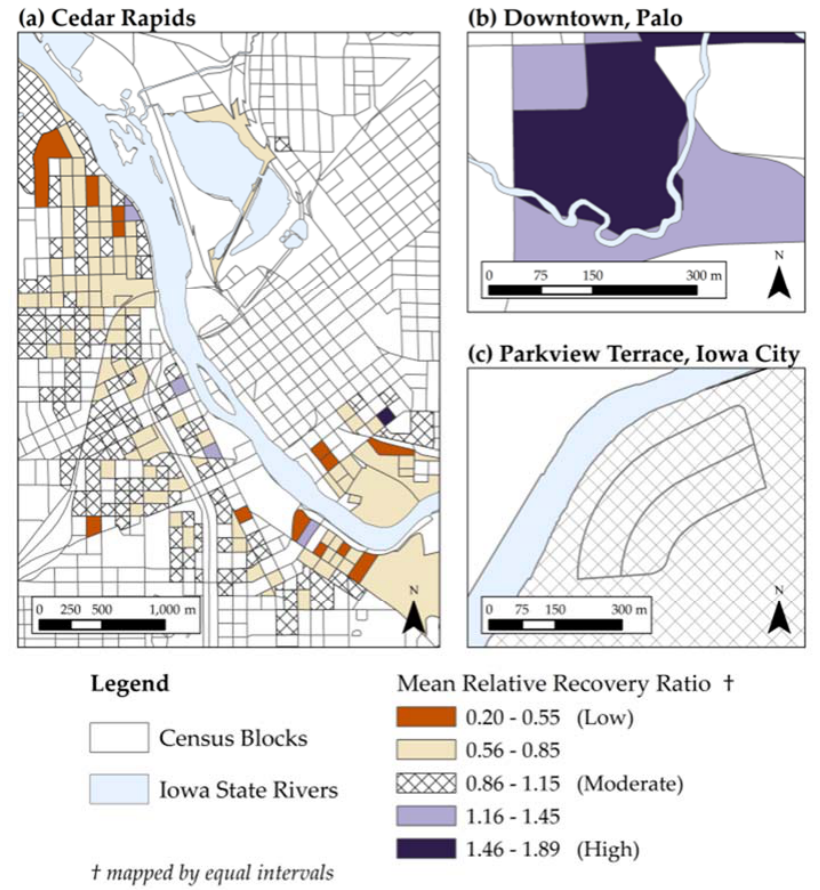
Figure 3. Spatial distribution of RRR values by city: ( a ) Cedar Rapids; ( b ) Downtown, Palo; ( c ) Parkview Terrance, Iowa City.